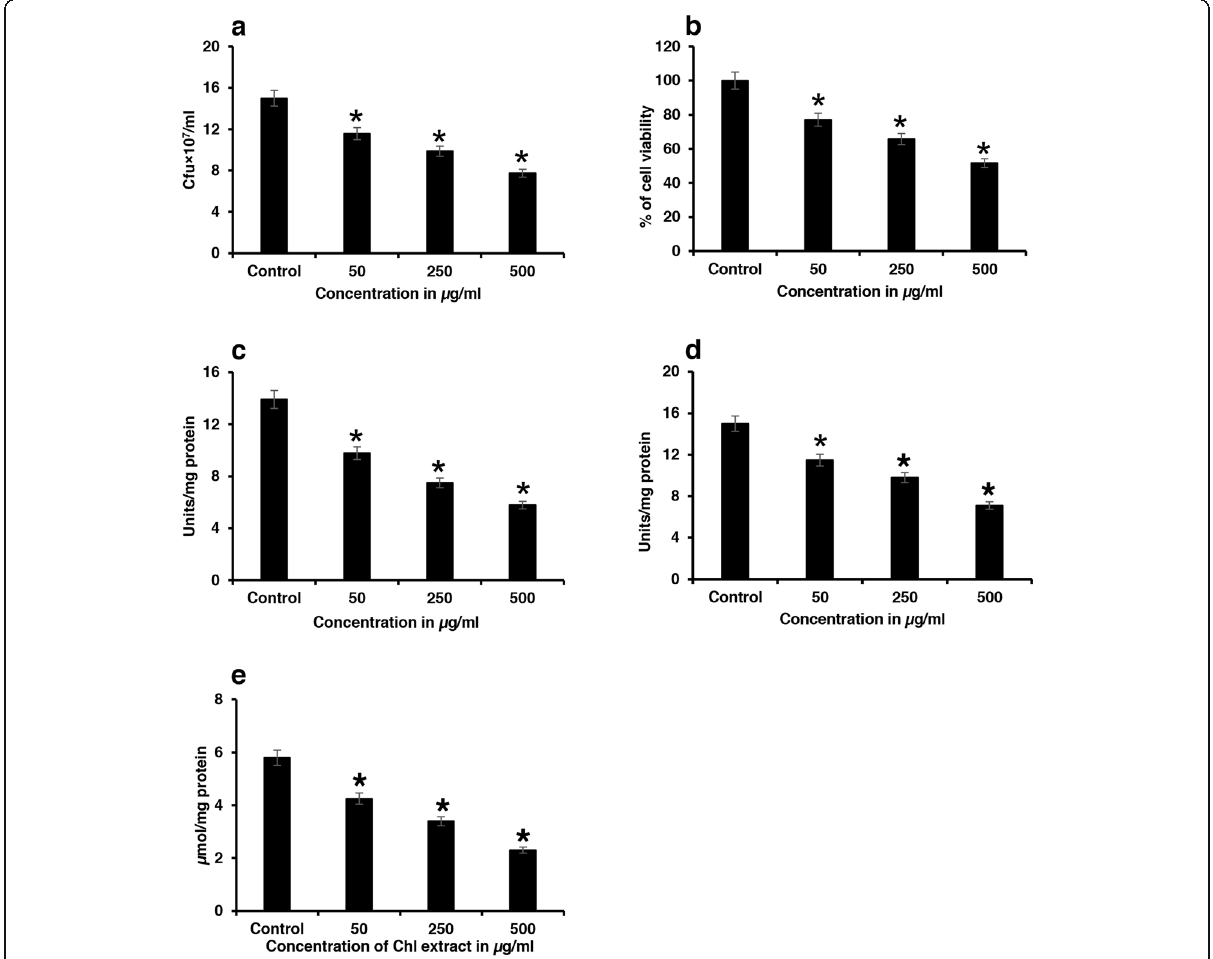
Fig. 3 The cfu/ml count in dose-dependent methanolic extract of C. vulgaris ( a ), % of cell viability ( b ). The SOD ( c ), CAT ( d ), and GSH ( e ) activity post-dose-dependent treatment of methanolic extract of the C.